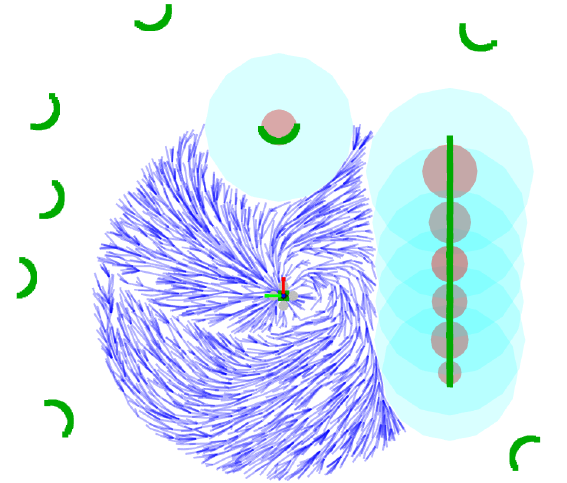
Figure 6. Simulation where a micro air vehicle (MAV) is flying in a forest with several trees and a long obstacle, such as a wall. LiDAR data is shown in green. If the obstacle is within the region of interest, it is approximated by a circle (brown disk). The light-blue region shows the expanded obstacle and the dark-blue graph represents the planner’s search